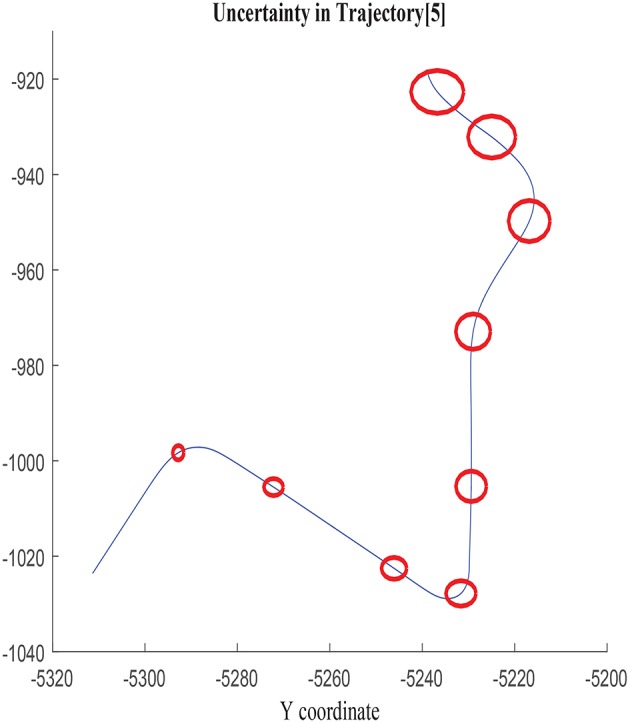
Error ellipses in σx, σy, and covxy in trajectory 5.